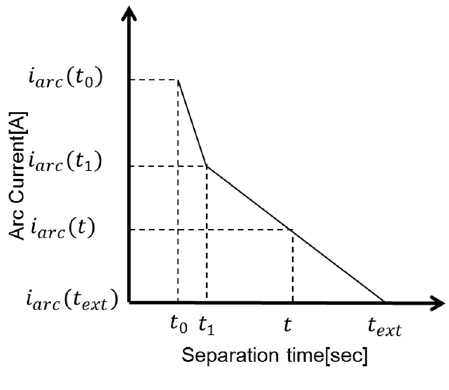
Figure 7. Arc current.